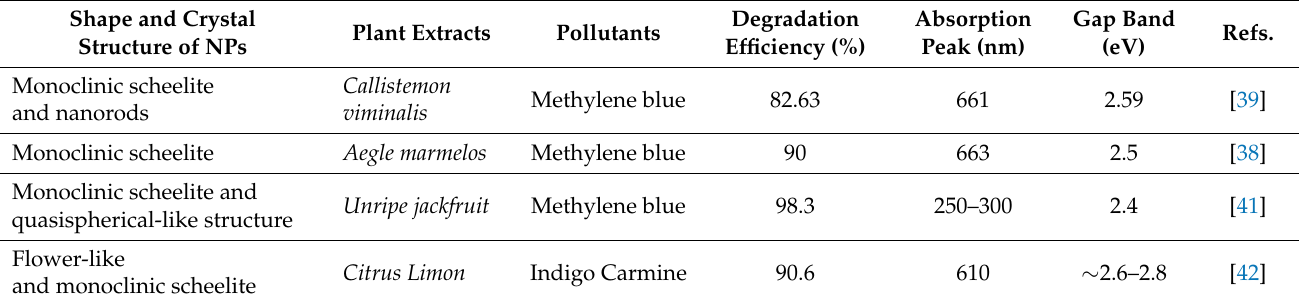
Table 2. Selected examples of photocatalytic degradation of pollutants using biosynthesized BiVO 4 NPs under visible light